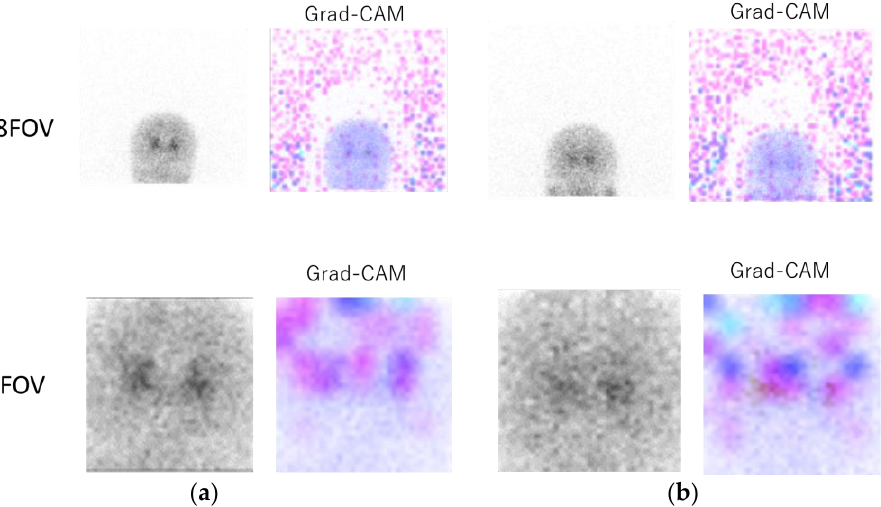
Figure 4. Upper part, image of the 128FOV and Gradient-weighted Class Activation Mapping (Grad-CAM)’s heat map; lower part, image of the 40FOV of the same case and the heat map image of Grad-CAM. ( a ) In the Grad-CAM of 128FOV, the many background dots indicate that the convolutional neural network (CNN) focused on the background. The 40FOV of the same case in the bottom shows that the small FOV was centered on the striatum, and CNN focused on the brain. ( b ) A case of [ 123 I] ioflupane ([ 123 I]-FP-CIT) accumulation in the parotid gland. In the Grad-CAM of the 128FOV ( top ), the color dots in the parotid gland indicate that the CNN focused on the parotid gland in addition to the background, while the image of the 40FOV ( bottom ) was cropped around the striatum, and the parotid gland was outside the field of view, indicating that the CNN was not interested in parotid accumulation.